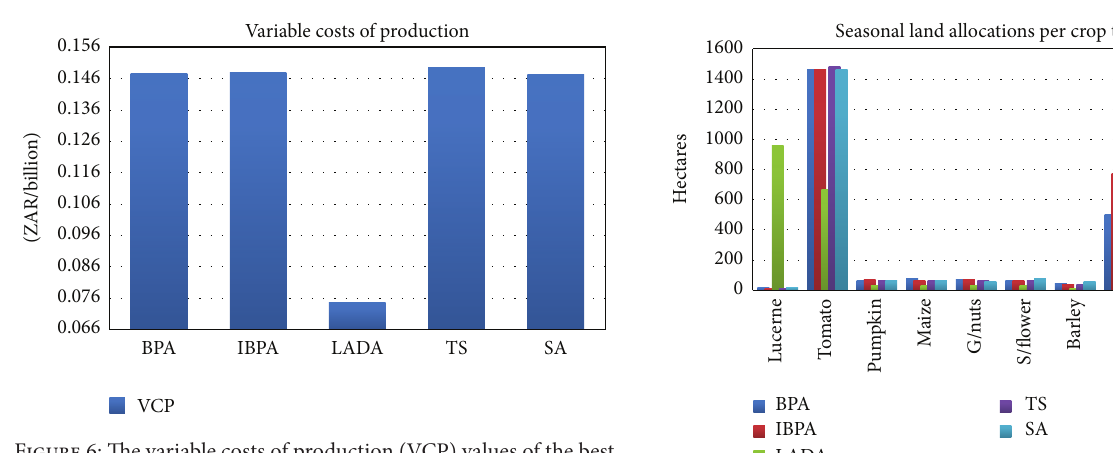
Figure 6: The variable costs of production (VCP) values of the best heuristic solutions. Table 7: Plot-type hectare allocations for each heuristic algorithm. Methods Single-crop plots Double-crop plots